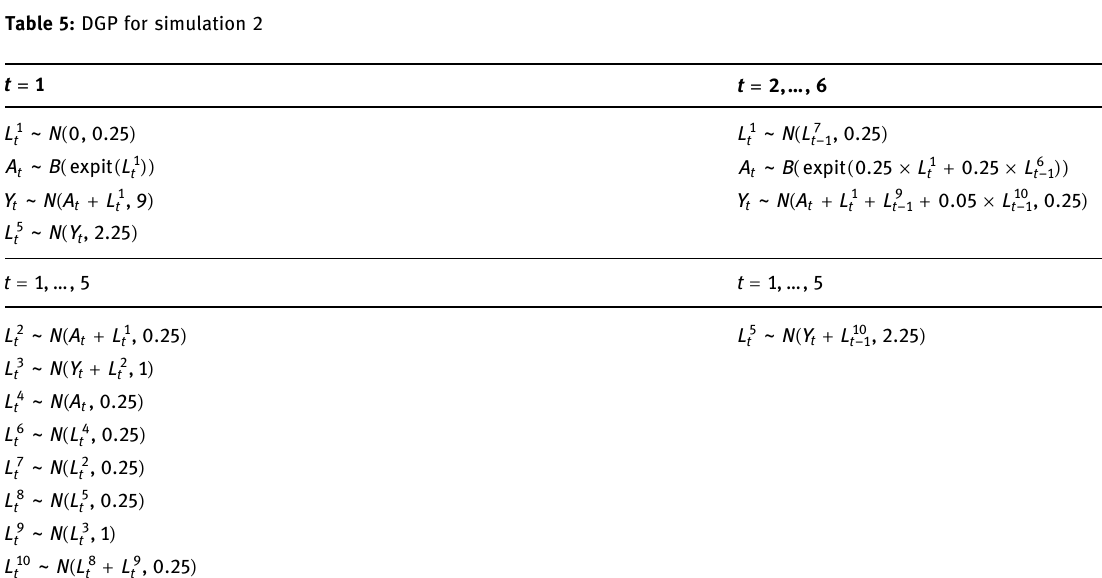
Table 5: DGP for simulation